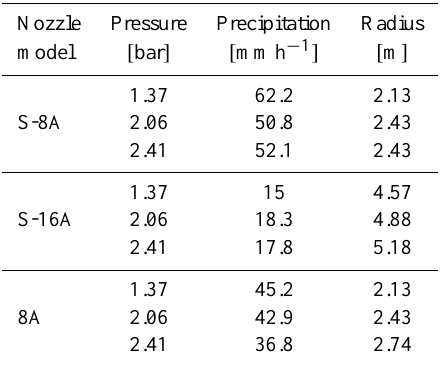
Table 1. Specification of the nozzles used in this study, given by the